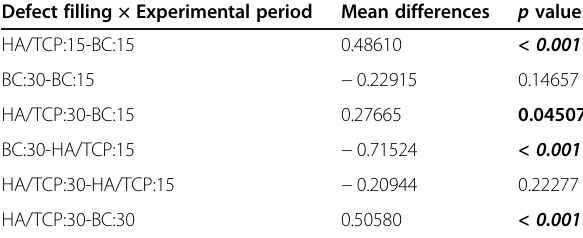
Table 1 Multiple comparisons of trabecular number Defect filling × Experimental